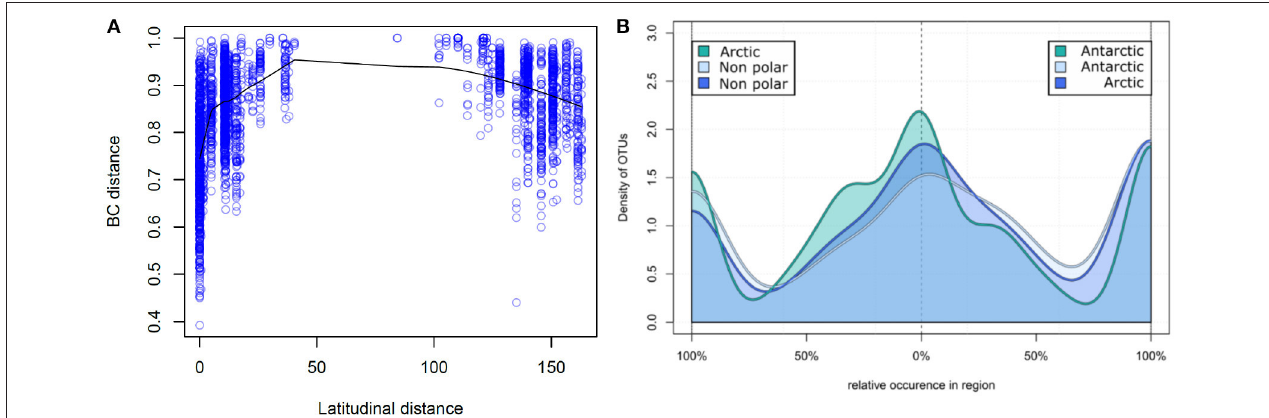
FIGURE 4 | Relative occurrence of operational taxonomic units: (A) Correlation of latitudinal distance and sample dissimilarity. The Bray–Curtis dissimilarity between two samples is displayed correlating to their distance in latitude degrees. Samples closer to the poles share a higher number of OTUs and therefore have a higher community similarity. (B) Relative occurrence of OTUs between major biomes. Unique and shared relative occurrence of OTUs are compared between each pair of the three major biomes (Arctic, Antarctic, and non-polar regions). For better comparability the number of samples was rarefied to seven per region and for each OTU the proportion of occurrence between two regions calculated, so that local OTUs are on the left and right of the diagram whereas shared OTUs are in the